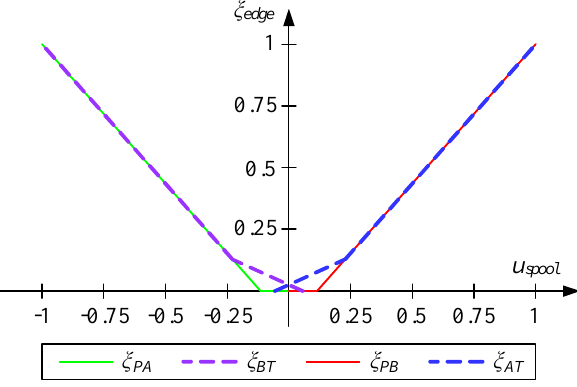
Figure 8: Opening functions for spool edges. The spool edge openings are piecewise linear functions